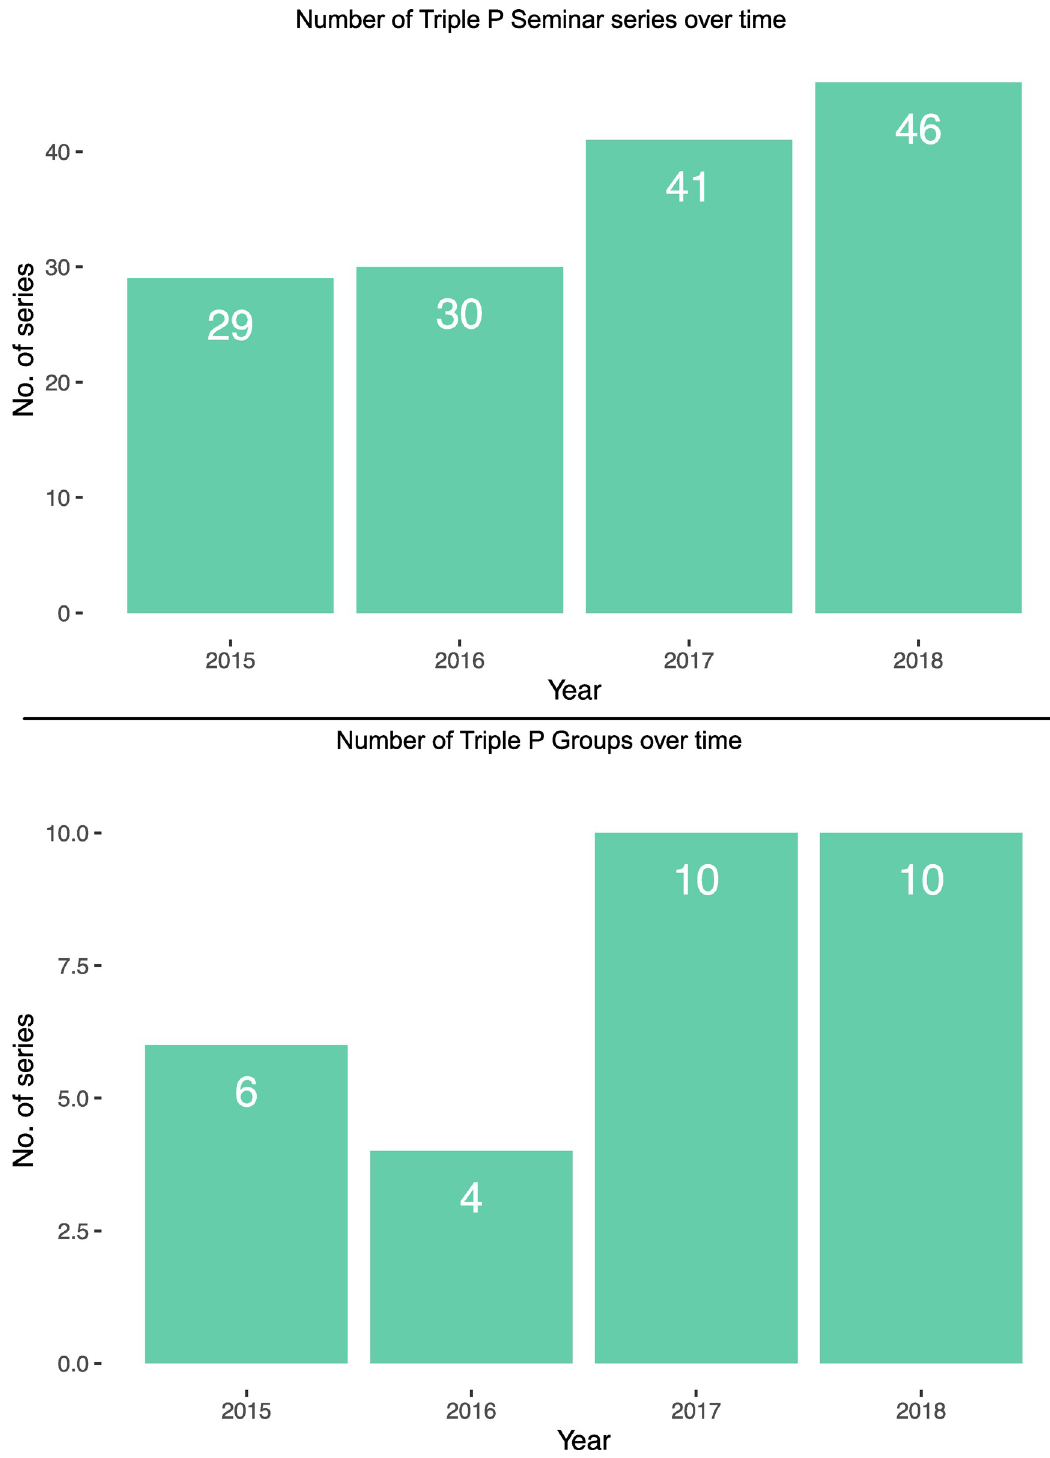
Fig 3. The number of seminar series and groups held over